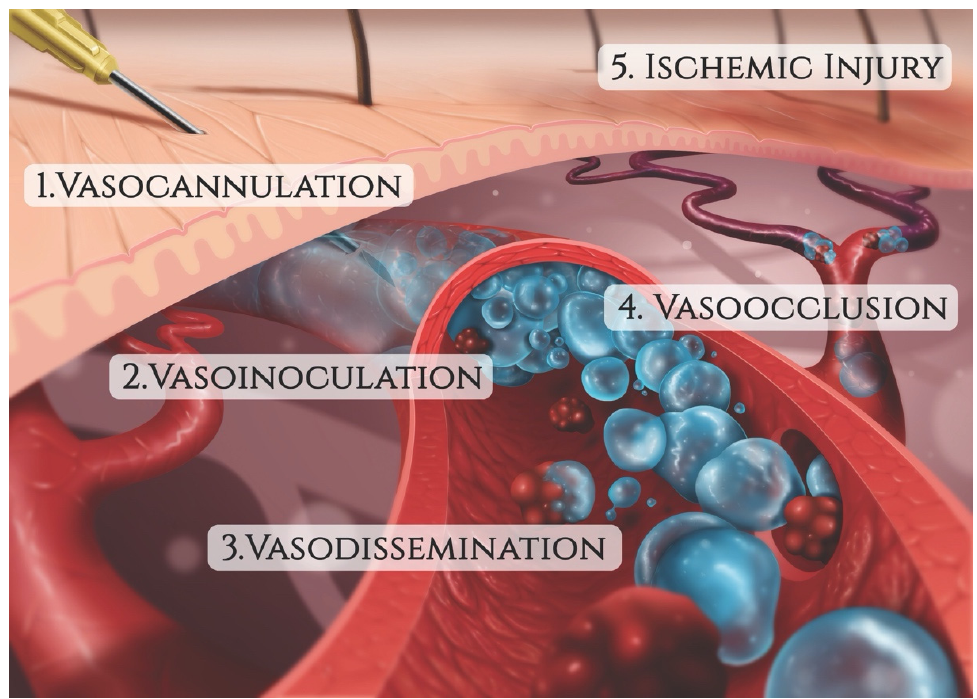
Figure 7. The sequence of events leading to filler-induced vascular occlusion